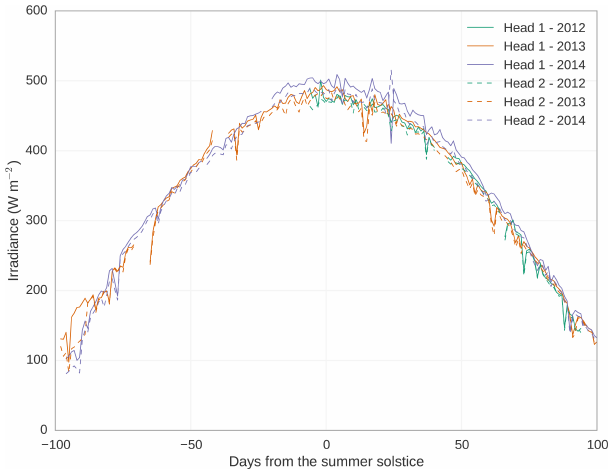
Figure 12. Temporal variations of downwelling irradiance mea- sured by the two heads, averaged every day between 12:00 and 14:00LT and averaged between 500 and 600nm for three summer seasons (the year indicated in the legend refers to the month of De- cember).